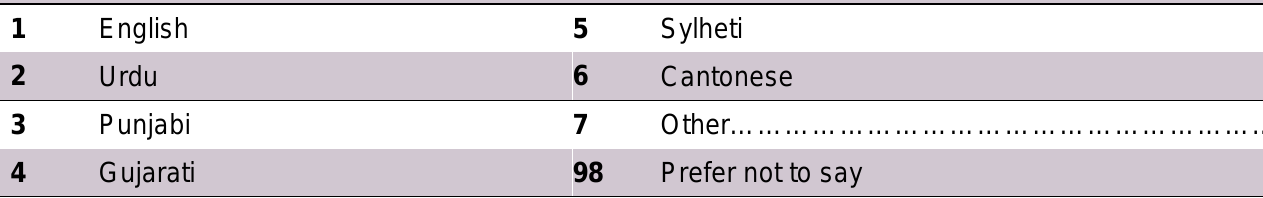
Cervical Cancer Awareness Measure Toolkit Version 2.1 Updated